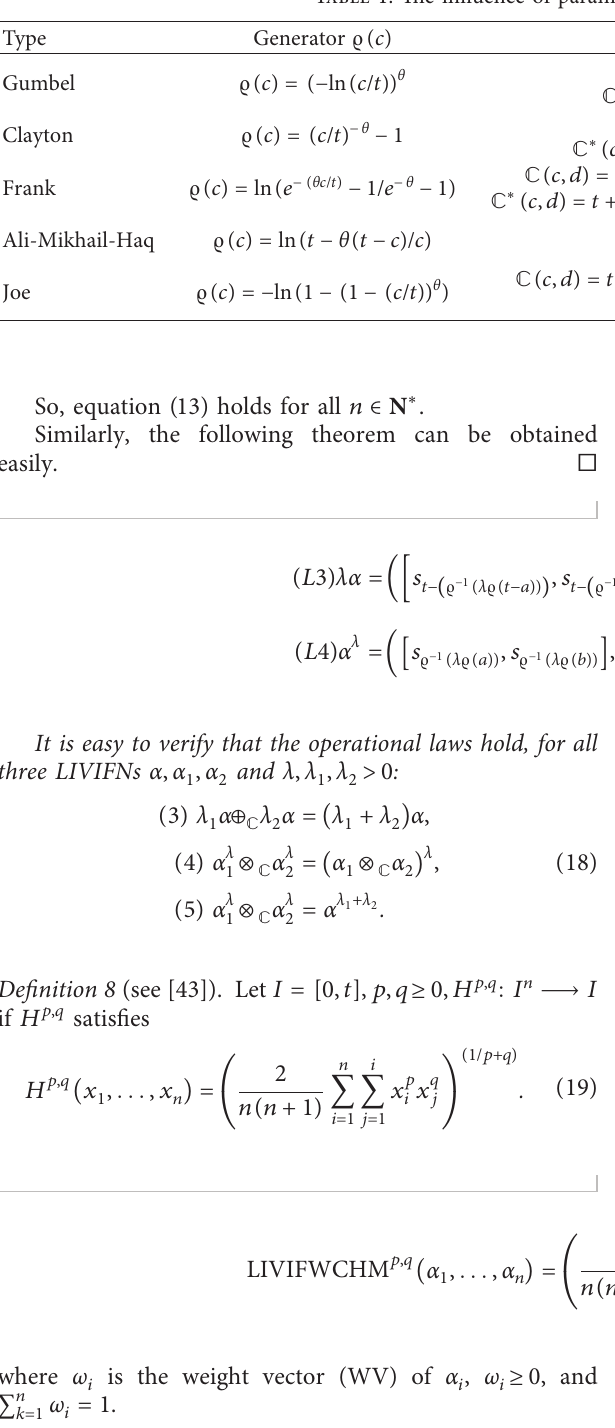
Table 1: The influence of parameter θ on the rank of